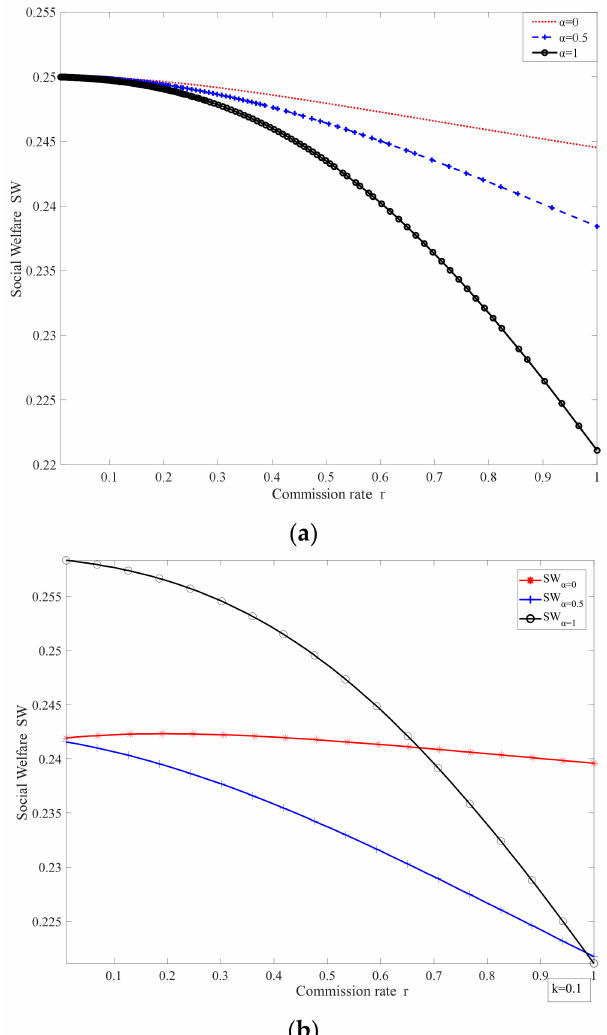
Figure 8. ( a ) The impact of commission rates r on social welfare (without privacy benefits). ( b ) The impact of commission rate r on social welfare (with consumer privacy